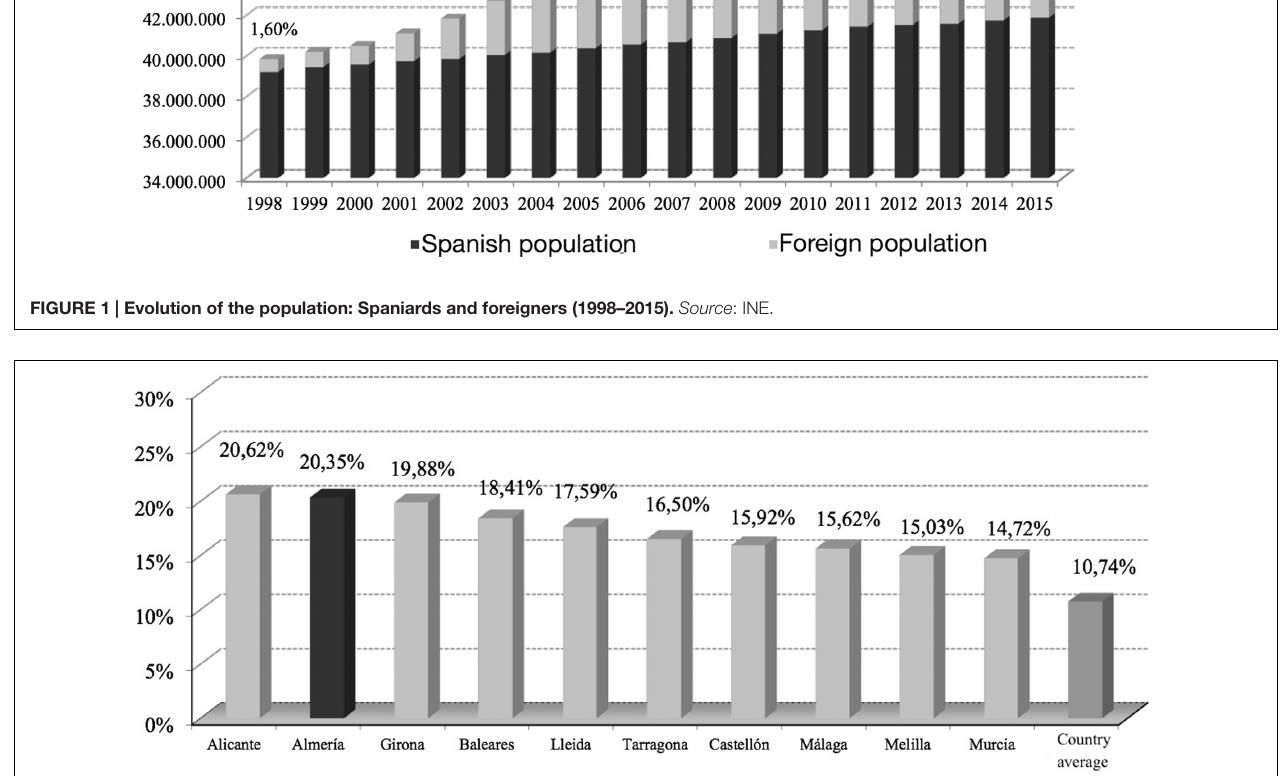
FIGURE 2 | Provinces with greater weight of foreigners on the total population (2014). Source :